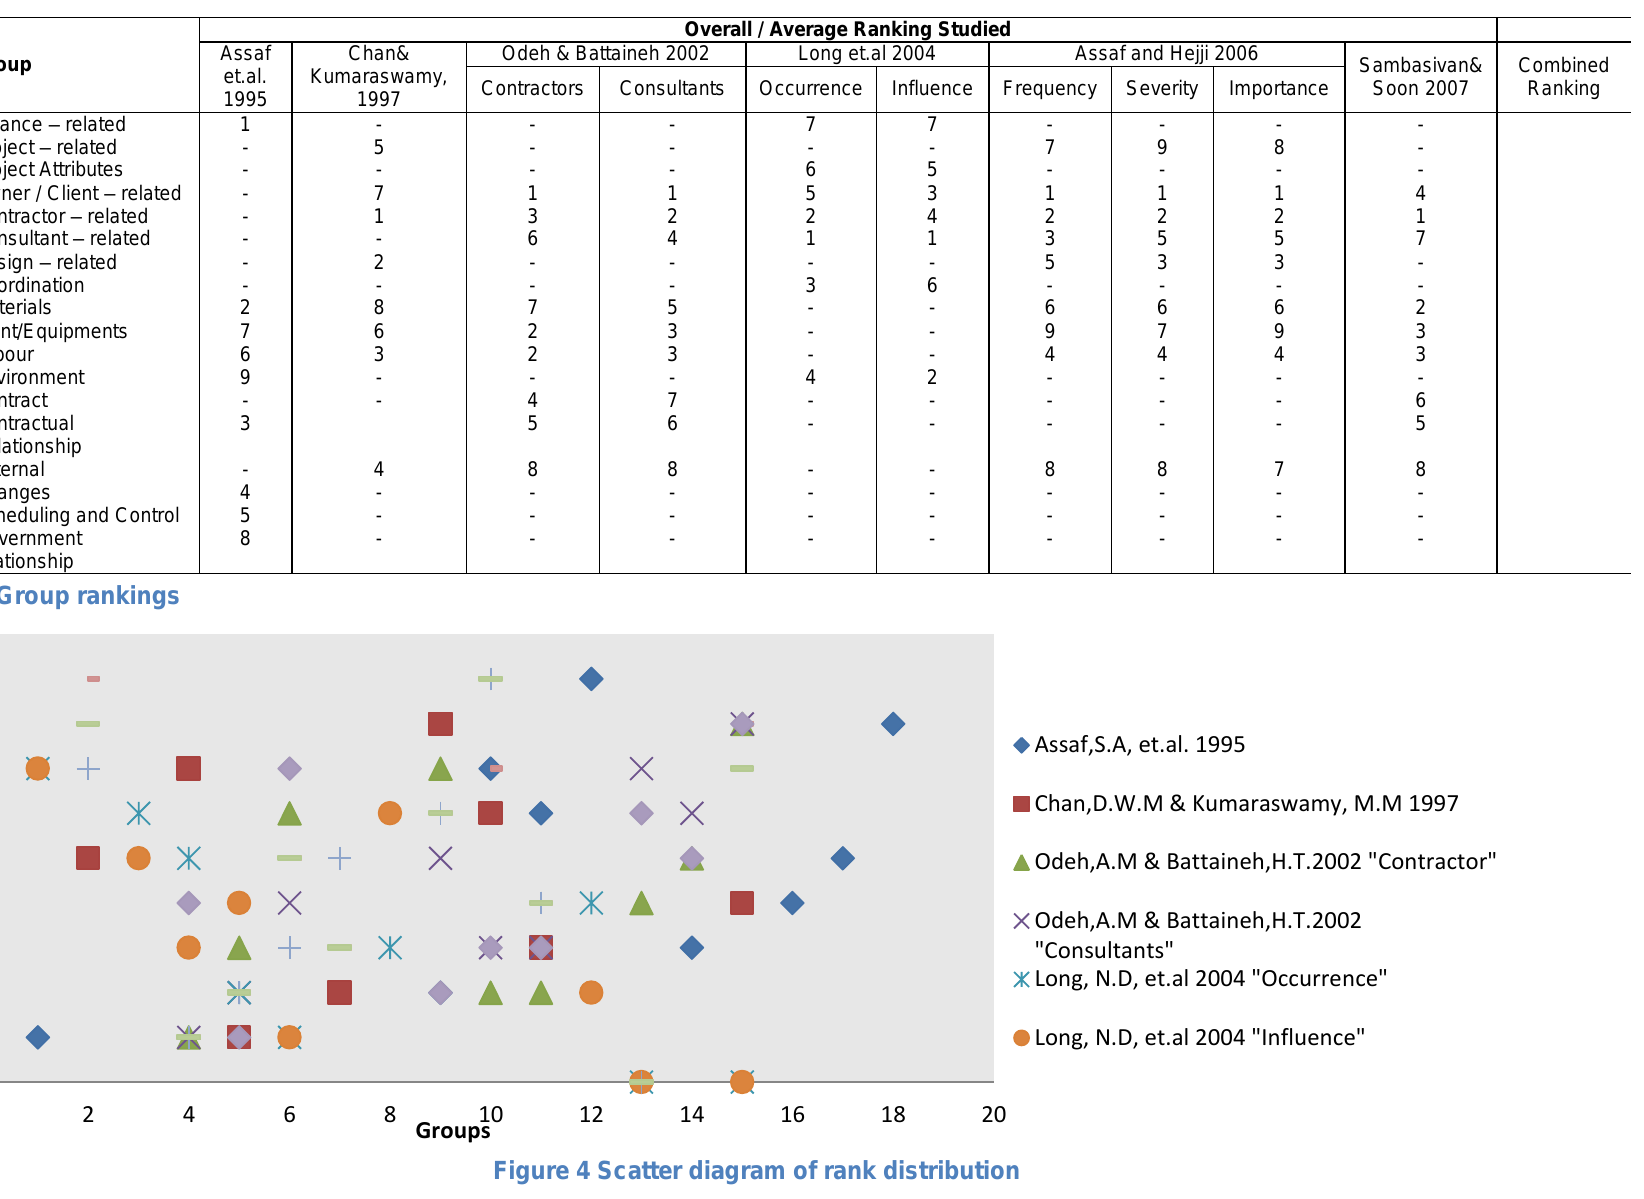
Figure 4 Scatter diagram of rank